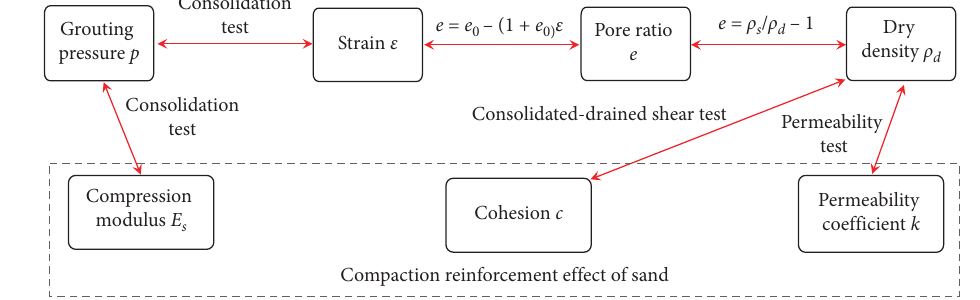
Figure 7: Logical connections between physical parameters.